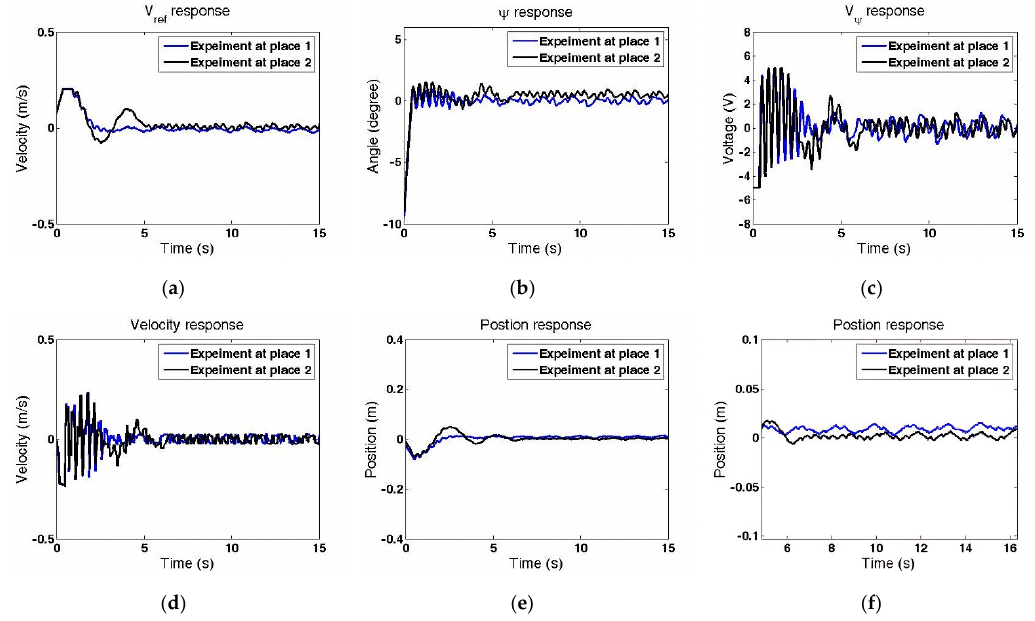
Figure 9. The experimental results of position control with P ref = 0: ( a ) Online V ref adjustment; ( b ) ψ responses; ( c ) Control signal V ψ ( t ) ; ( d ) Velocity responses v ( t ) ; ( e ) Position responses p ( t ) ; ( f ) Zoom-in plot of ( d ). Table 2. Balancing analyses using the position loop control.